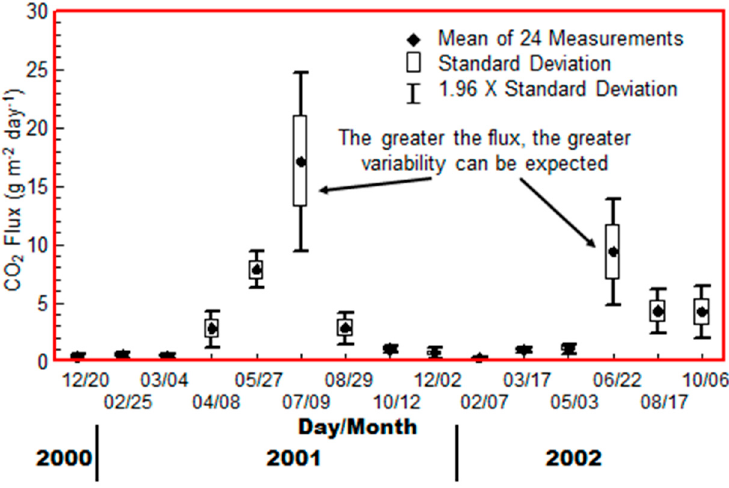
Figure 3. Carbon dioxide seasonal flux measurements at the Control Site (modified from Klusman [11]).